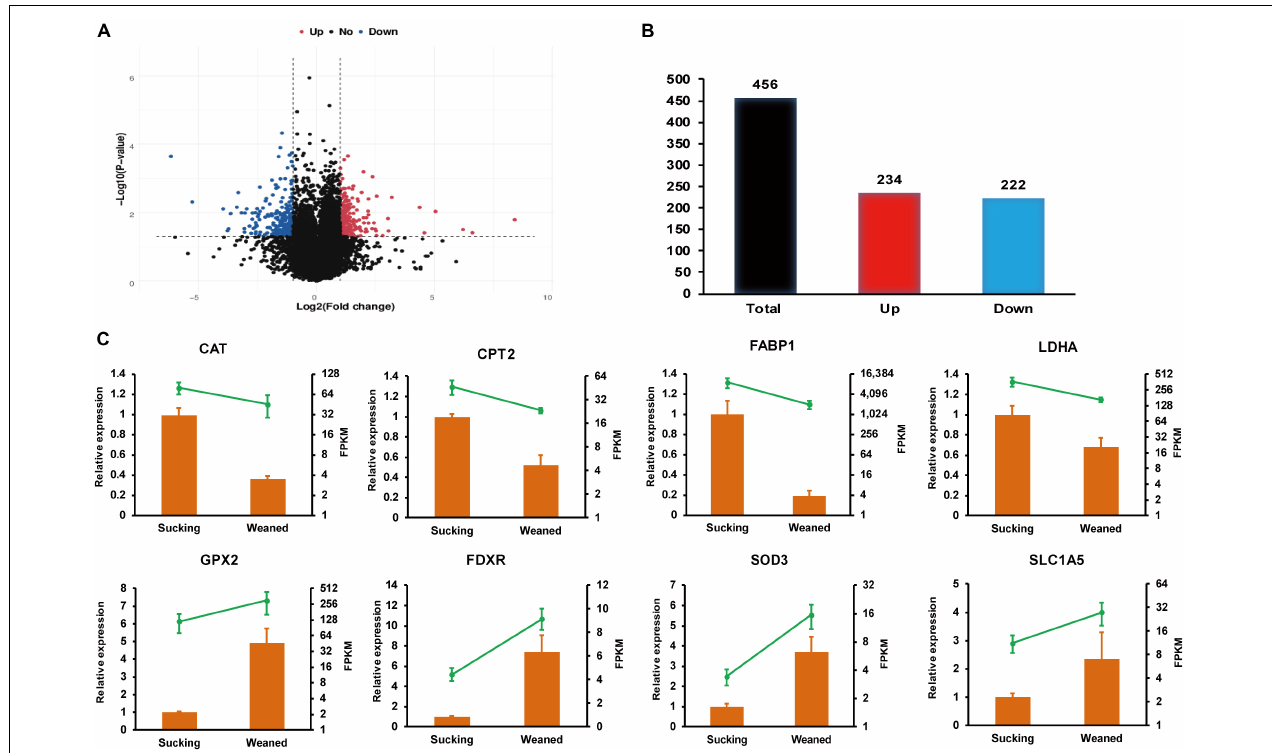
FIGURE 2 | RNA-seq analysis of the intestines of sucking piglets and weaned piglets. (A) Volcano plot of DEGs; fold-changes were calculated as weaned piglets/sucking piglets. (B) Number of up-regulated and down-regulated DEGs. (C) Relative expression levels from qRT-PCR and FPKM from RNA-seq analysis; the mRNA levels of the selected genes were analyzed by qRT-PCR and normalized to those of GAPDH ; all values are expressed as the means ± SEMs ( n = 3).